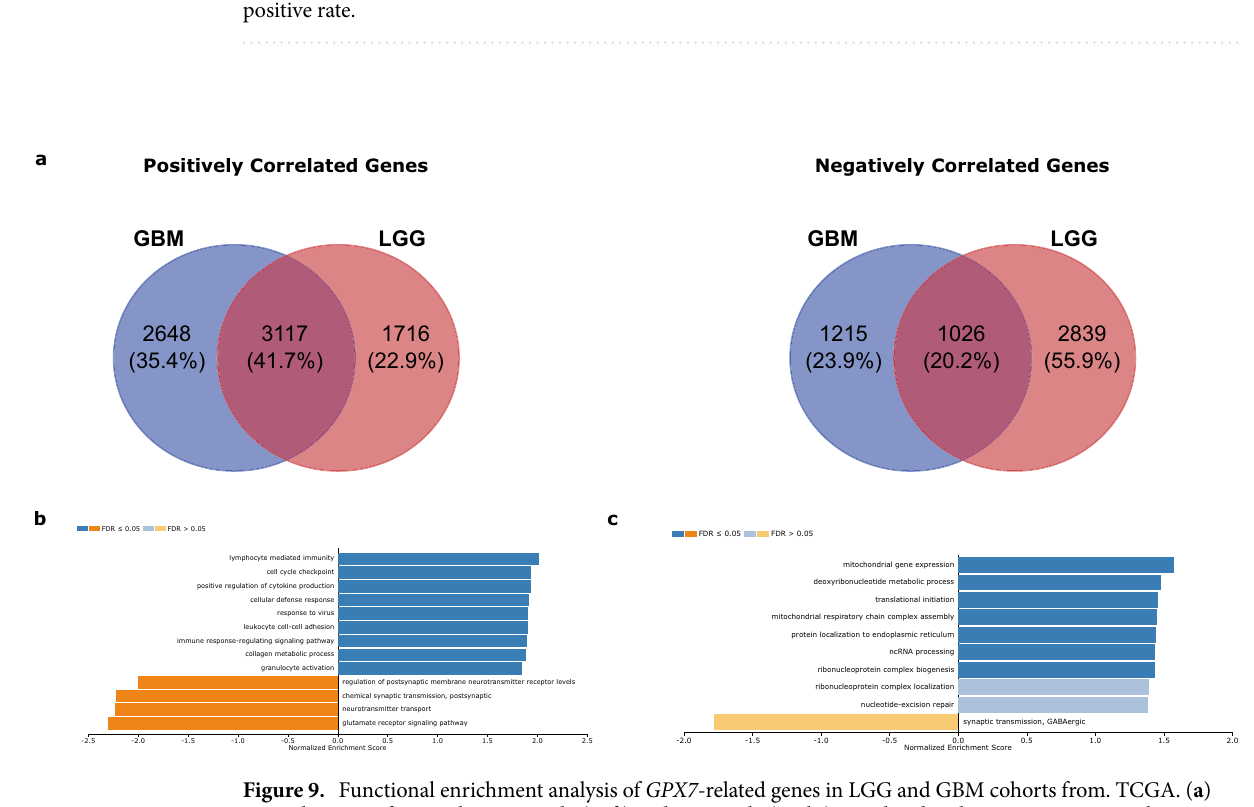
Figure 9. Functional enrichment analysis of GPX7 -related genes in LGG and GBM cohorts from. TCGA. ( a ) Venn diagram of genes that positively (Left) and negatively (Right) correlated with GPX7 expression, showing shared genes in LGG and GBM. ( b ) Functional annotation using GSEA shows an overrepresentation of Gene Ontology (GO) terms of upregulated (blue) and downregulated (orange) genes co-expressed with GPX7 in LGG. ( c ) Functional annotation using GSEA shows an overrepresentation of Gene Ontology (GO) terms of upregulated (blue) and downregulated (orange) genes co-expressed with GPX7 in GBM. Dark blue and orange: FDR ⩽ 0.05; Light blue and orange: FDR > 0.05. Abbreviations: FDR: false discovery rate; GO: Gene